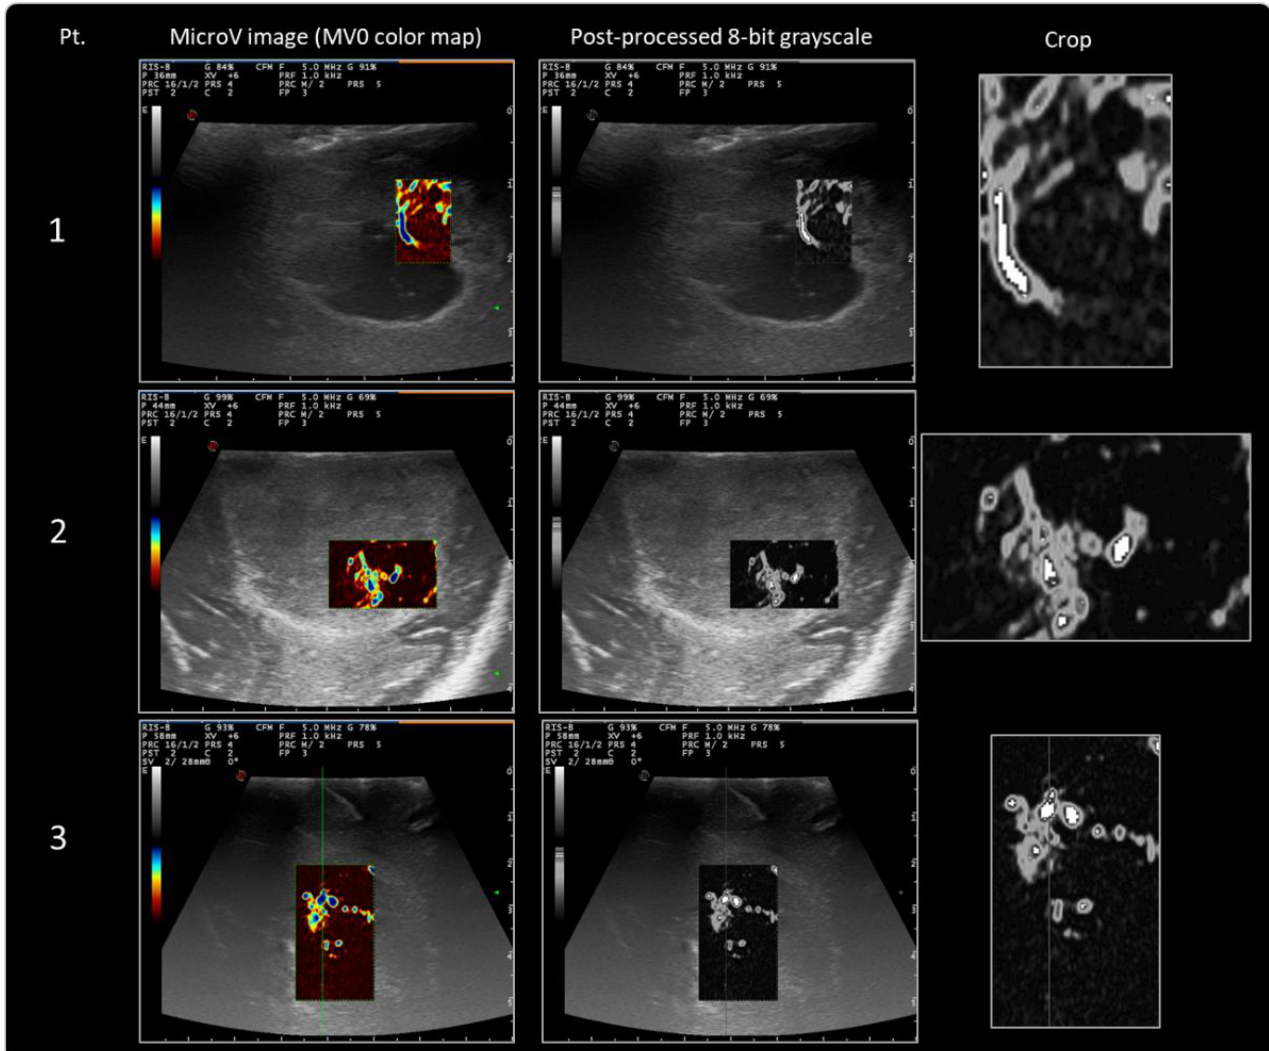
Figure 3. Graphic data from first-order radiomic analysis performed with ImageJ on the first eight GBM patients as specified in Table 2. Area in expressed in px 2 on secondary Y-axis.